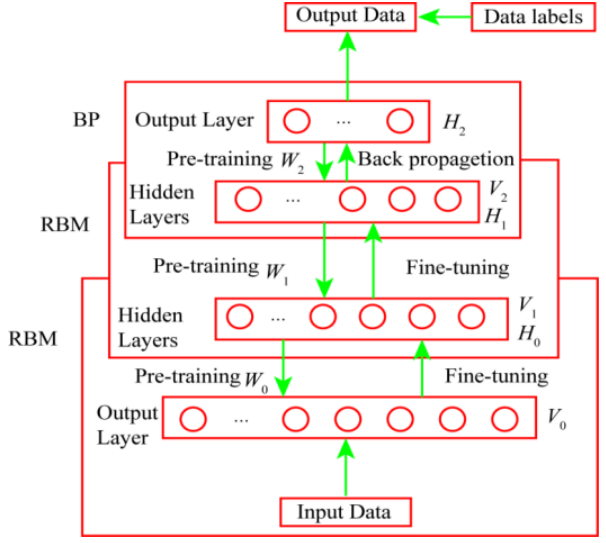
Figure 1. DBN’s classic architecture